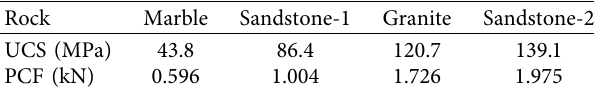
Table 3: The PCF with different UCS.